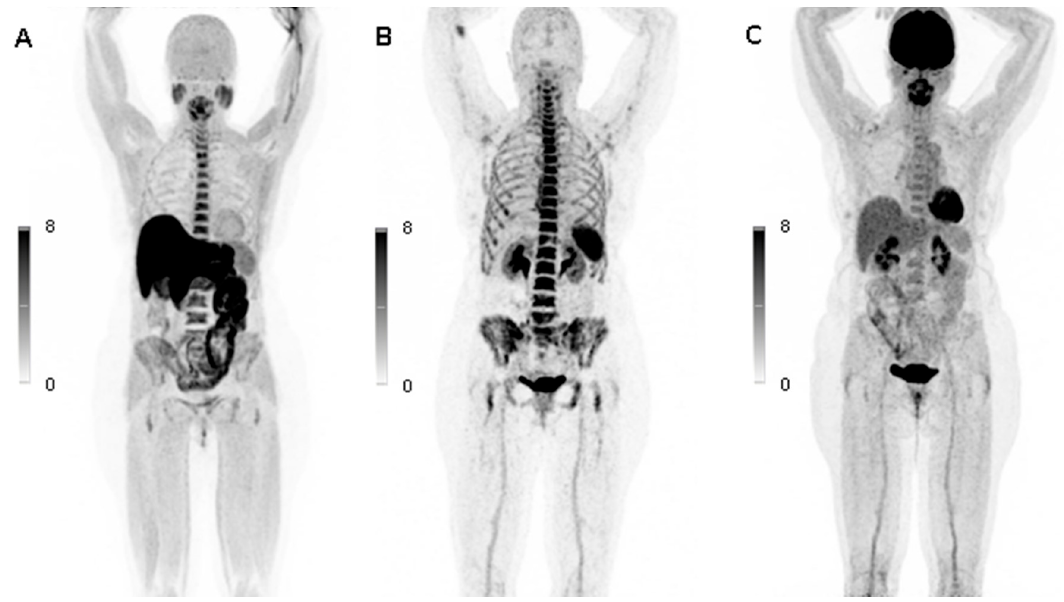
Figure 5. 11C-Methionine, 68Ga-Pentixafor, and 18F-FDG PET/CT scans in a patient with smoldering multiple myeloma (SMM): The figure shows a patient (No. 1 in Tables 1 and 2) with SMM who had a bone marrow plasma cell infiltration rate of 40%. 11C-Methionine ( A ) and 68Ga-Pentixafor PET/CT scans ( B ) presented increased tracer uptake which correlated with plasma cell infiltration (e.g., spine and pelvis), while the standard 18F-FDG PET/CT scan ( C ) showed physiological tracer uptake in the entire skeleton.